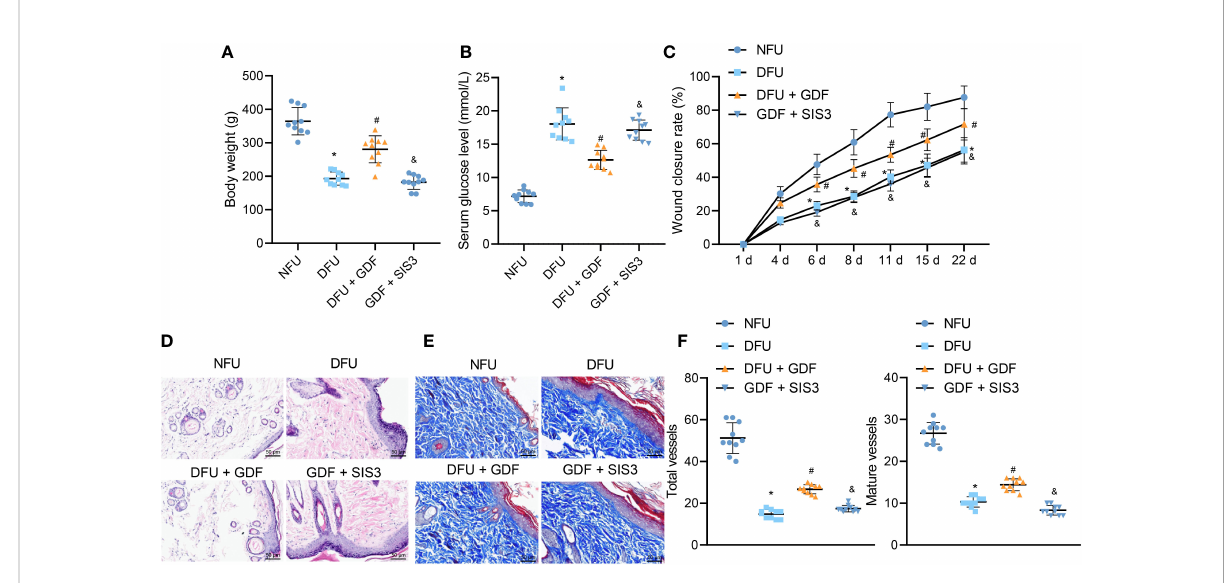
FIGURE 6 Effects of GDF10-stimulated angiogenesis on the wound healing in DFU rats. (A) , Rat weight. (B) , Blood glucose of rats after fasting. (C) , Representative picture of DFU rats after GDF10 treatment. (D) , HE staining of pathological changes in control rats and DFU rats of different treatment. (E) , Masson trichrome staining of collagen deposition in control rats and DFU rats of different treatment. (F) Immuno fl uorescence detection of angiogenesis in wounds: red fl uorescent marks a -SMA, green fl uorescent marks CD31, and blue fl uorescent marks nucleus. Measurement data were expressed in the form of mean ± standard deviation. One-way ANOVA was used for comparison between multiple groups, and repeated measures ANOVA was used to compare data between groups at different times. * p < 0. 05 vs. the NFU group. # p < 0.05 vs. the DFU group. & p < 0.05 vs. the DFU + GDF group. Ten rats were used in each